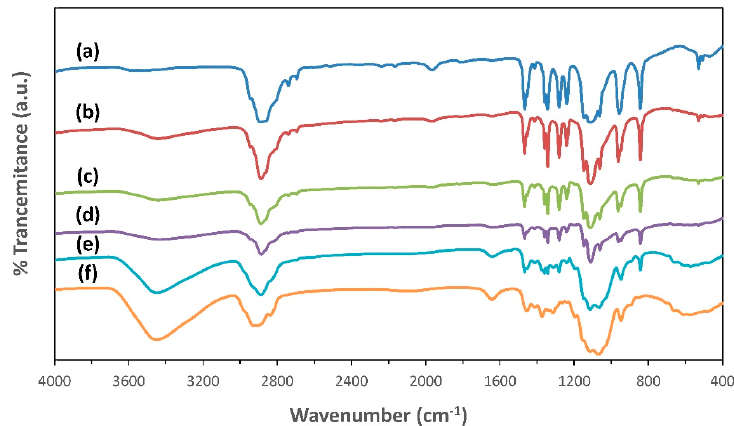
Figure 4. The FTIR spectra for: (a) Pure PEO; (b) PEO:MC blend weight ratio 80:20; (c) PEO:MC blend weight ratio 60:40; (d) PEO:MC blend weight ratio 40:60; (e) PEO:MC blend weight ratio 20:80; (f) Pure MC.